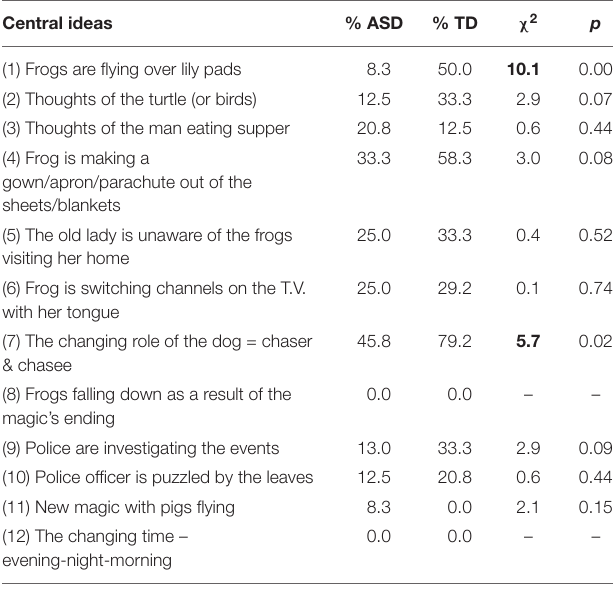
TABLE 3 | Comparison of percentages of participants in the ASD and TD groups who included each of the central ideas in their narratives. Central ideas